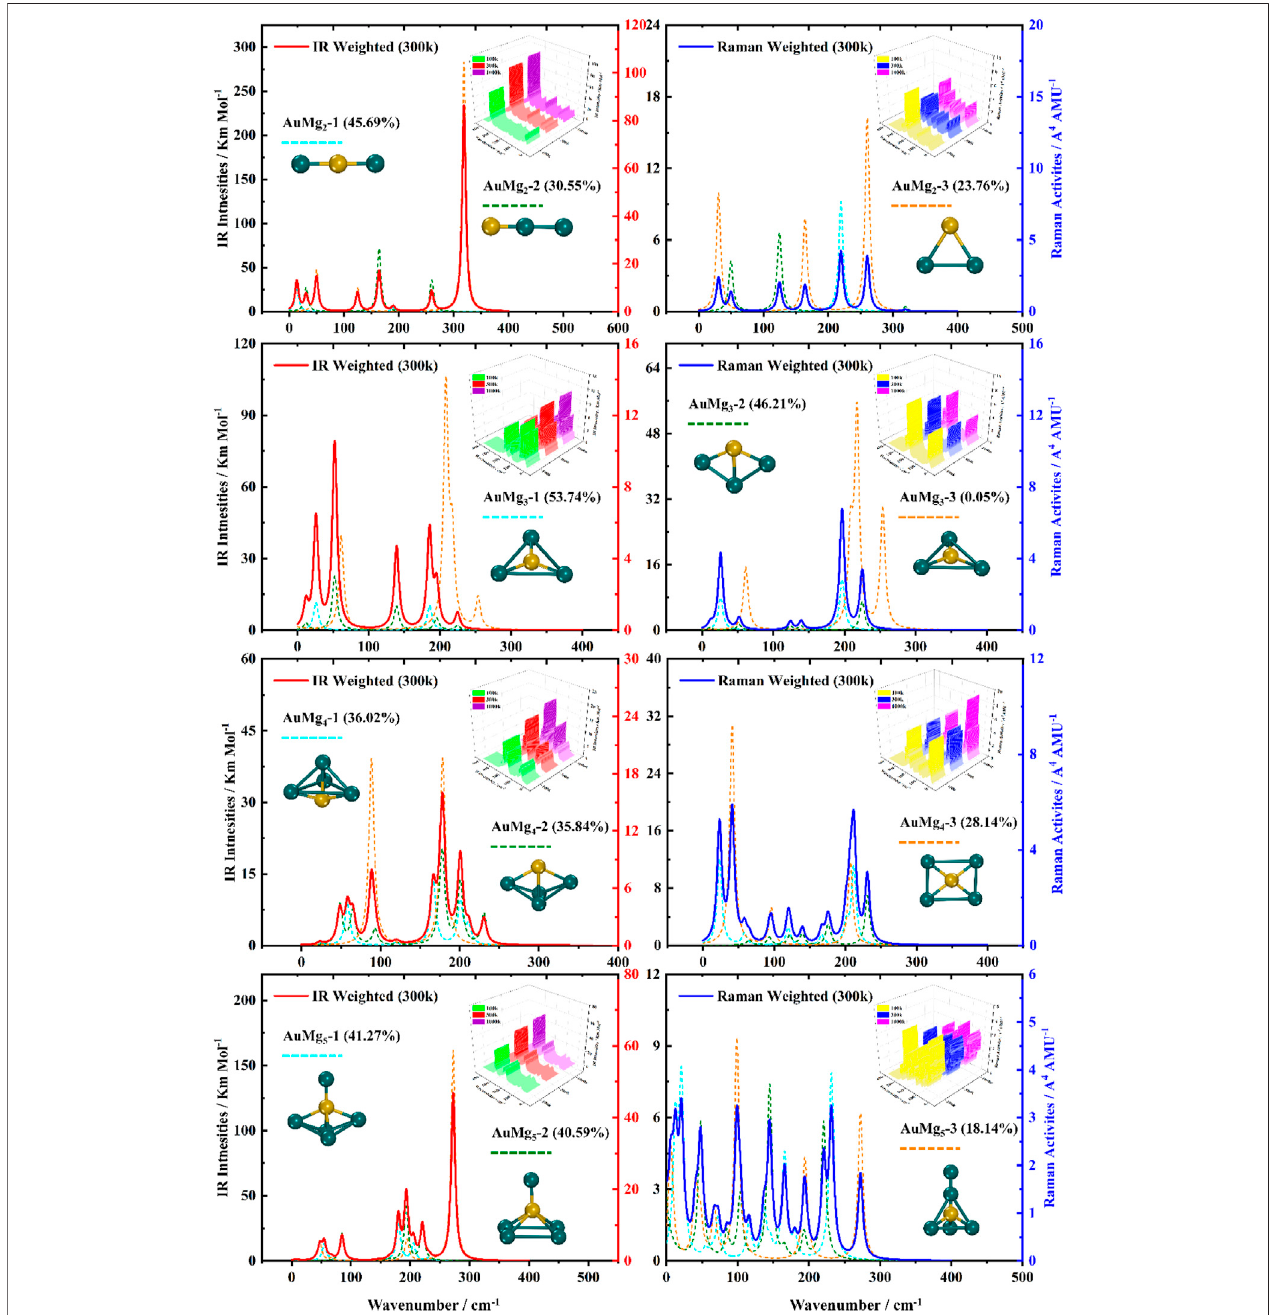
FIGURE 7 | Boltzmann distribution weighted average spectra of the three lowest energy isomers of AuMg n ( n = 2 – 5) nanoclusters at room temperature (IR on the left side, Raman on the right side).